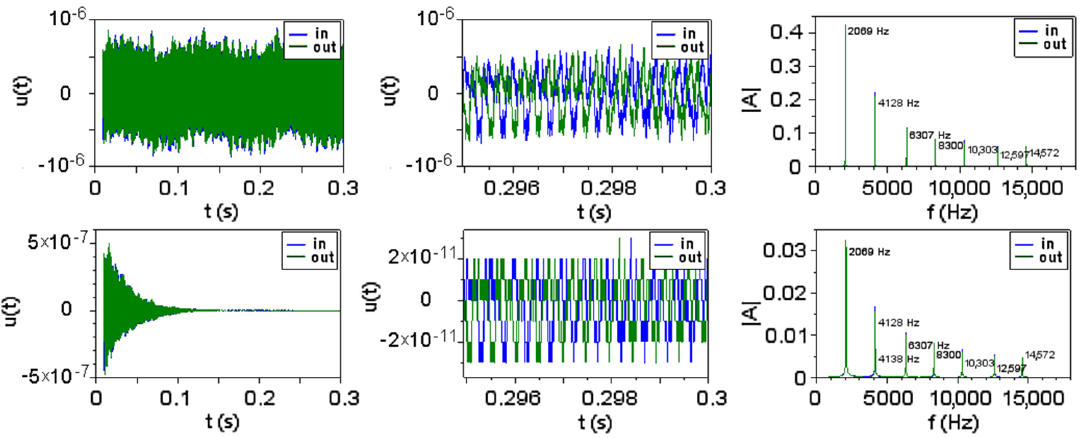
Figure 3. The eigenfrequencies of a brass-aluminum-brass system without (above) and with (below)